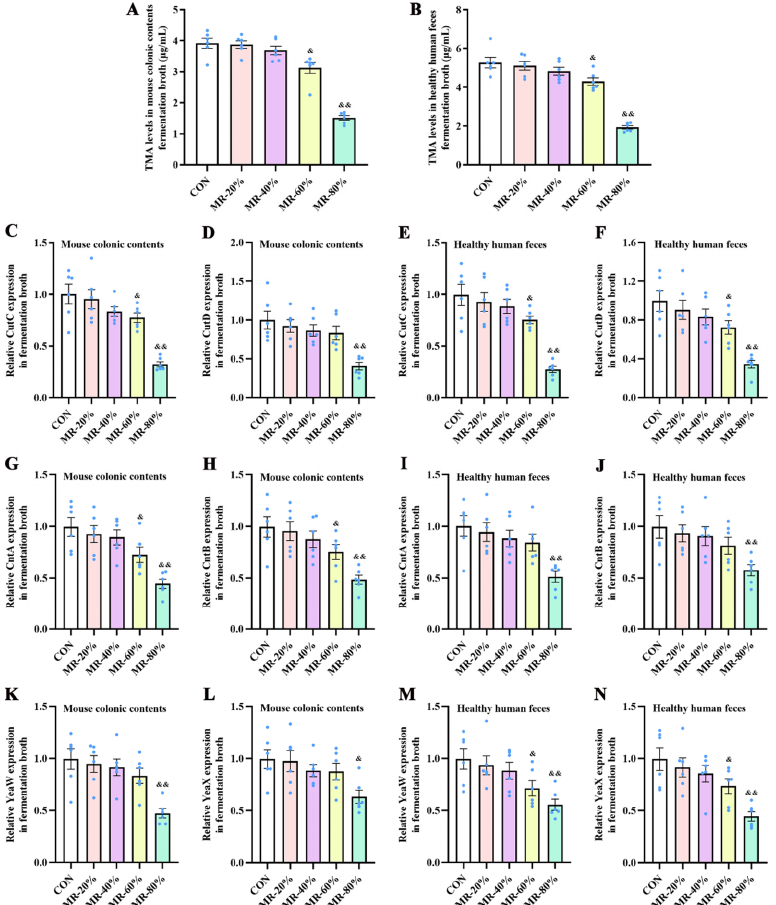
Figure 1. Effects of different levels of MR on TMA production by bacteria from mouse colonic contents ( A ) and healthy human feces ( B ) cultured anaerobically in fermentation medium, and on expression levels of CutC ( C , E ), CutD ( D , F ), CntA ( G , I ), CntB ( H , J ), YeaW ( K , M ), and YeaX ( L , N ) in bacteria from mouse colonic contents and healthy human feces cultured anaerobically in fermentation medium. TMA, trimethylamine; MR, methionine restriction; CON, 0.86% methionine; MR-20%, 0.69% methionine; MR-40%, 0.52% methionine; MR-60%, 0.34% methionine; MR-80%, 0.17% methionine. & p < 0.05, && p < 0.01, compared with the CON group.